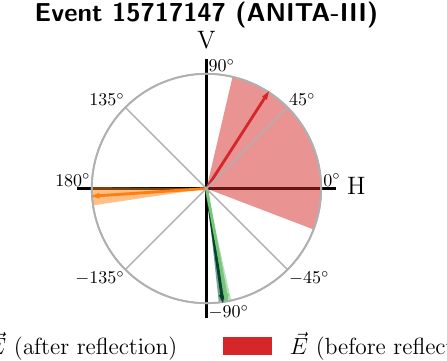
The shaded regions correspond to 1 σ uncertainties assuming a 4 . 6 ◦ uncertainty in the determination of the polarization direction [5], and a 2 ◦ uncertainty in the orientation of the Earth magnetic field